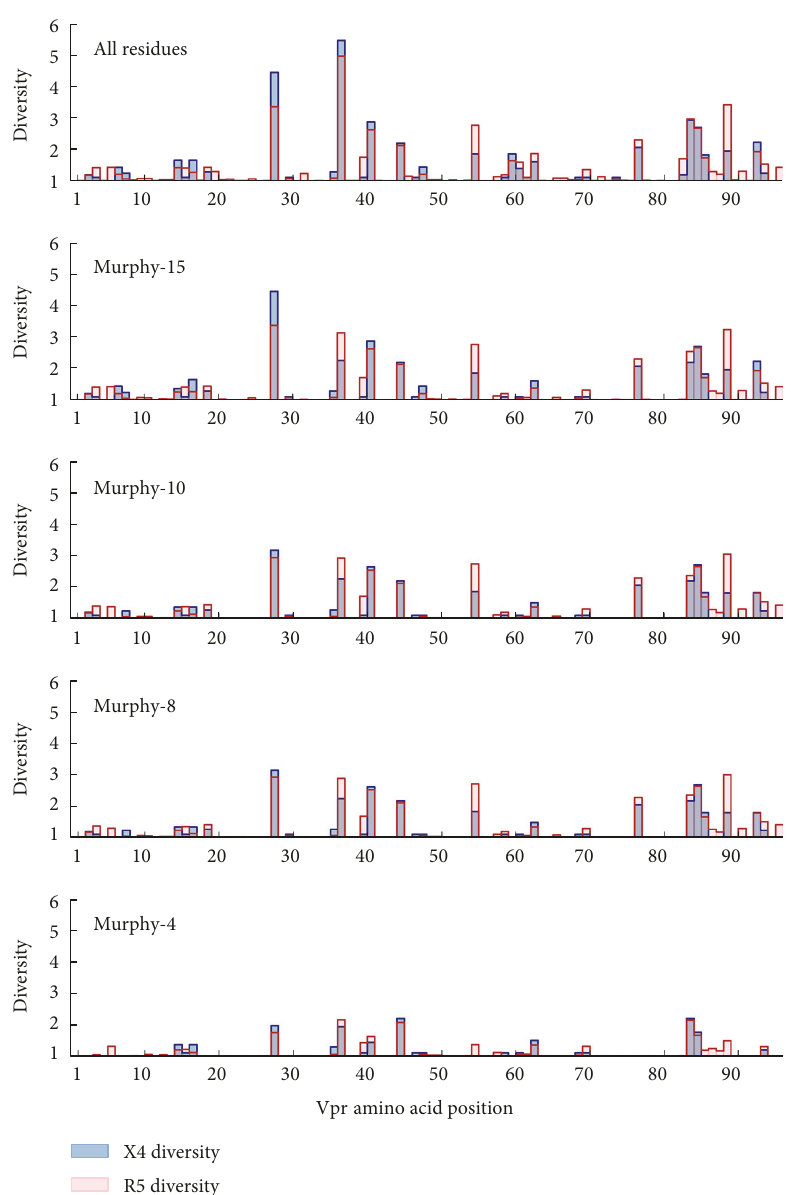
Figure 2: Position-speci fi c Vpr amino acid diversity is generally consistent across multiple amino acid alphabets but di ff erent between R5-and X4-associated sequences. The amino acid diversity was calculated across all positions of Vpr for both the R5 (red) and X4 (blue) sequence populations. While the overall levels of variation tended to be consistent between the two populations, there were notable di ff erences in amino acid diversity between the R5 and X4 populations that persisted across multiple alphabets at positions 28, 37, 55, and 89. Diversity values for amino acid positions at which at least one diversity value was greater than 2 in the full amino acid alphabet are listed in Table